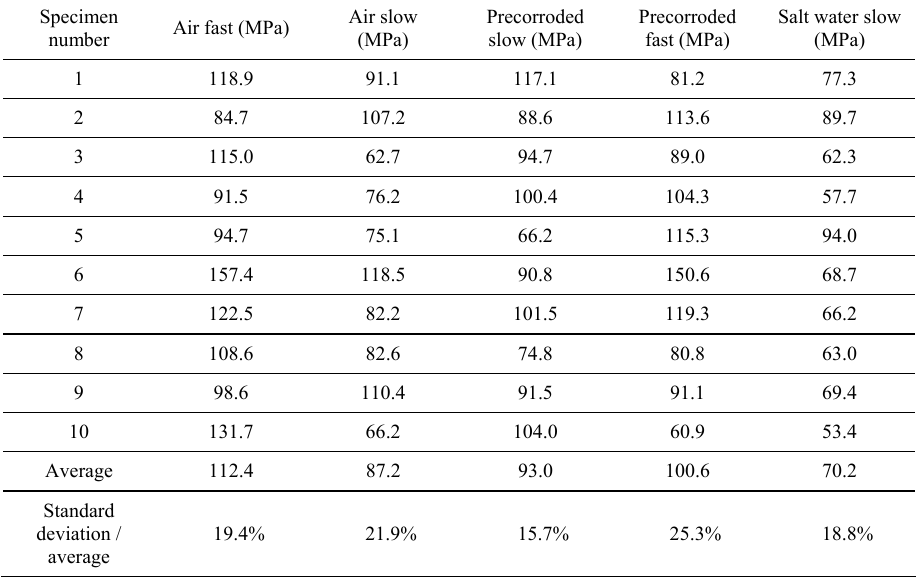
Table 2: Tests in air, salt water and pre-corroded specimens